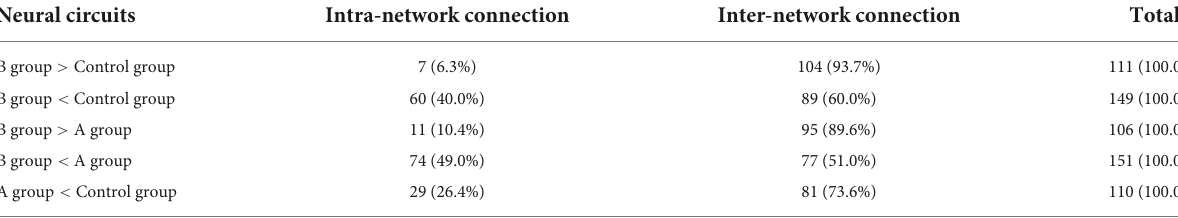
TABLE 3 Number of different types of edges in each neural circuits. Neural